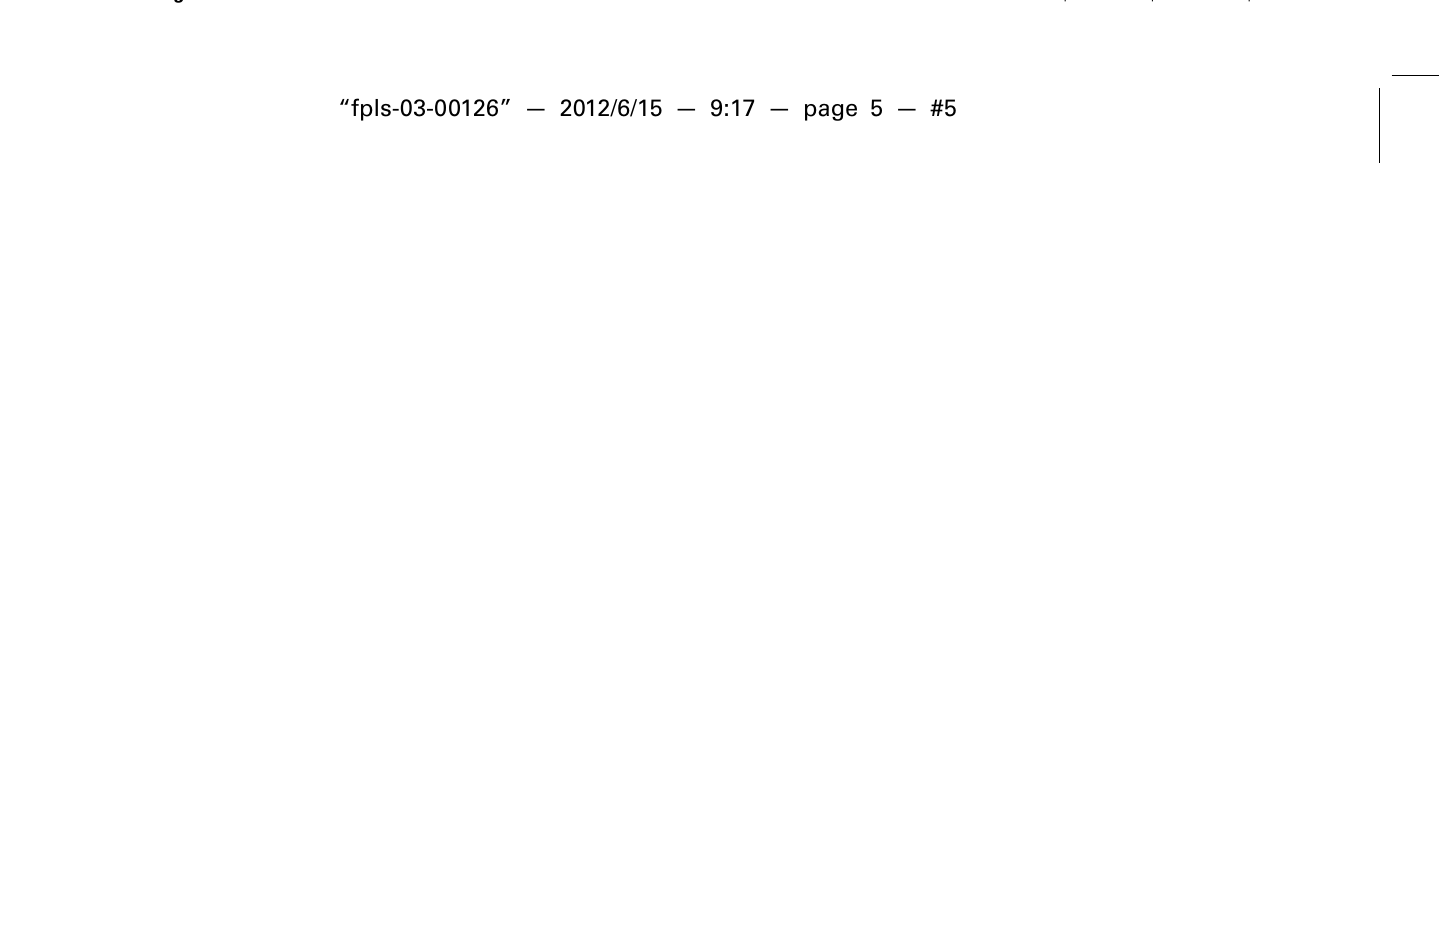
FIGURE 4 |Translocation of PLA 2 α to apoplasts was enhanced by the inoculation of bacteria, Pst-avrRpm1 , in pre-mature young leaves. (A–C) Images showing increased fluorescence intensity and vesicle sizes followed by the translocation of PLA 2 α to apoplasts at 3 h post-inoculation of